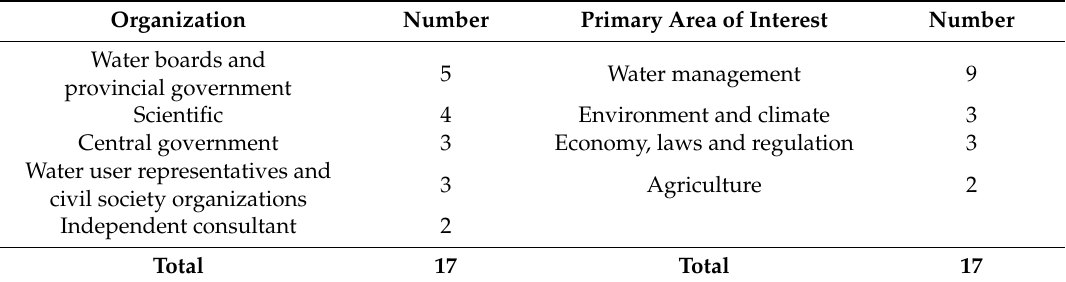
Table 1. Categorization of participants by organization and by primary area of